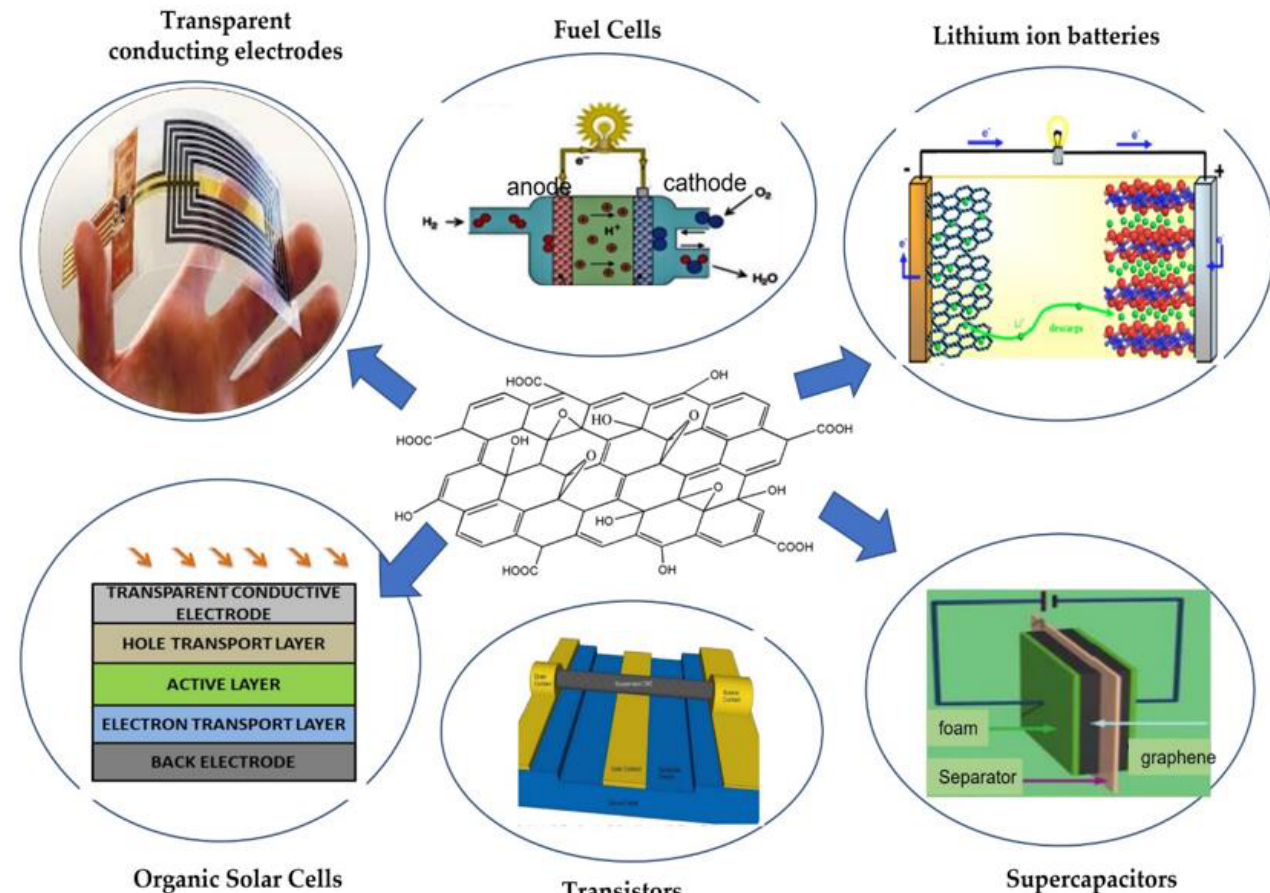
Scheme 14. Chart flow showing potential applications of graphene-polymer composites in the field of